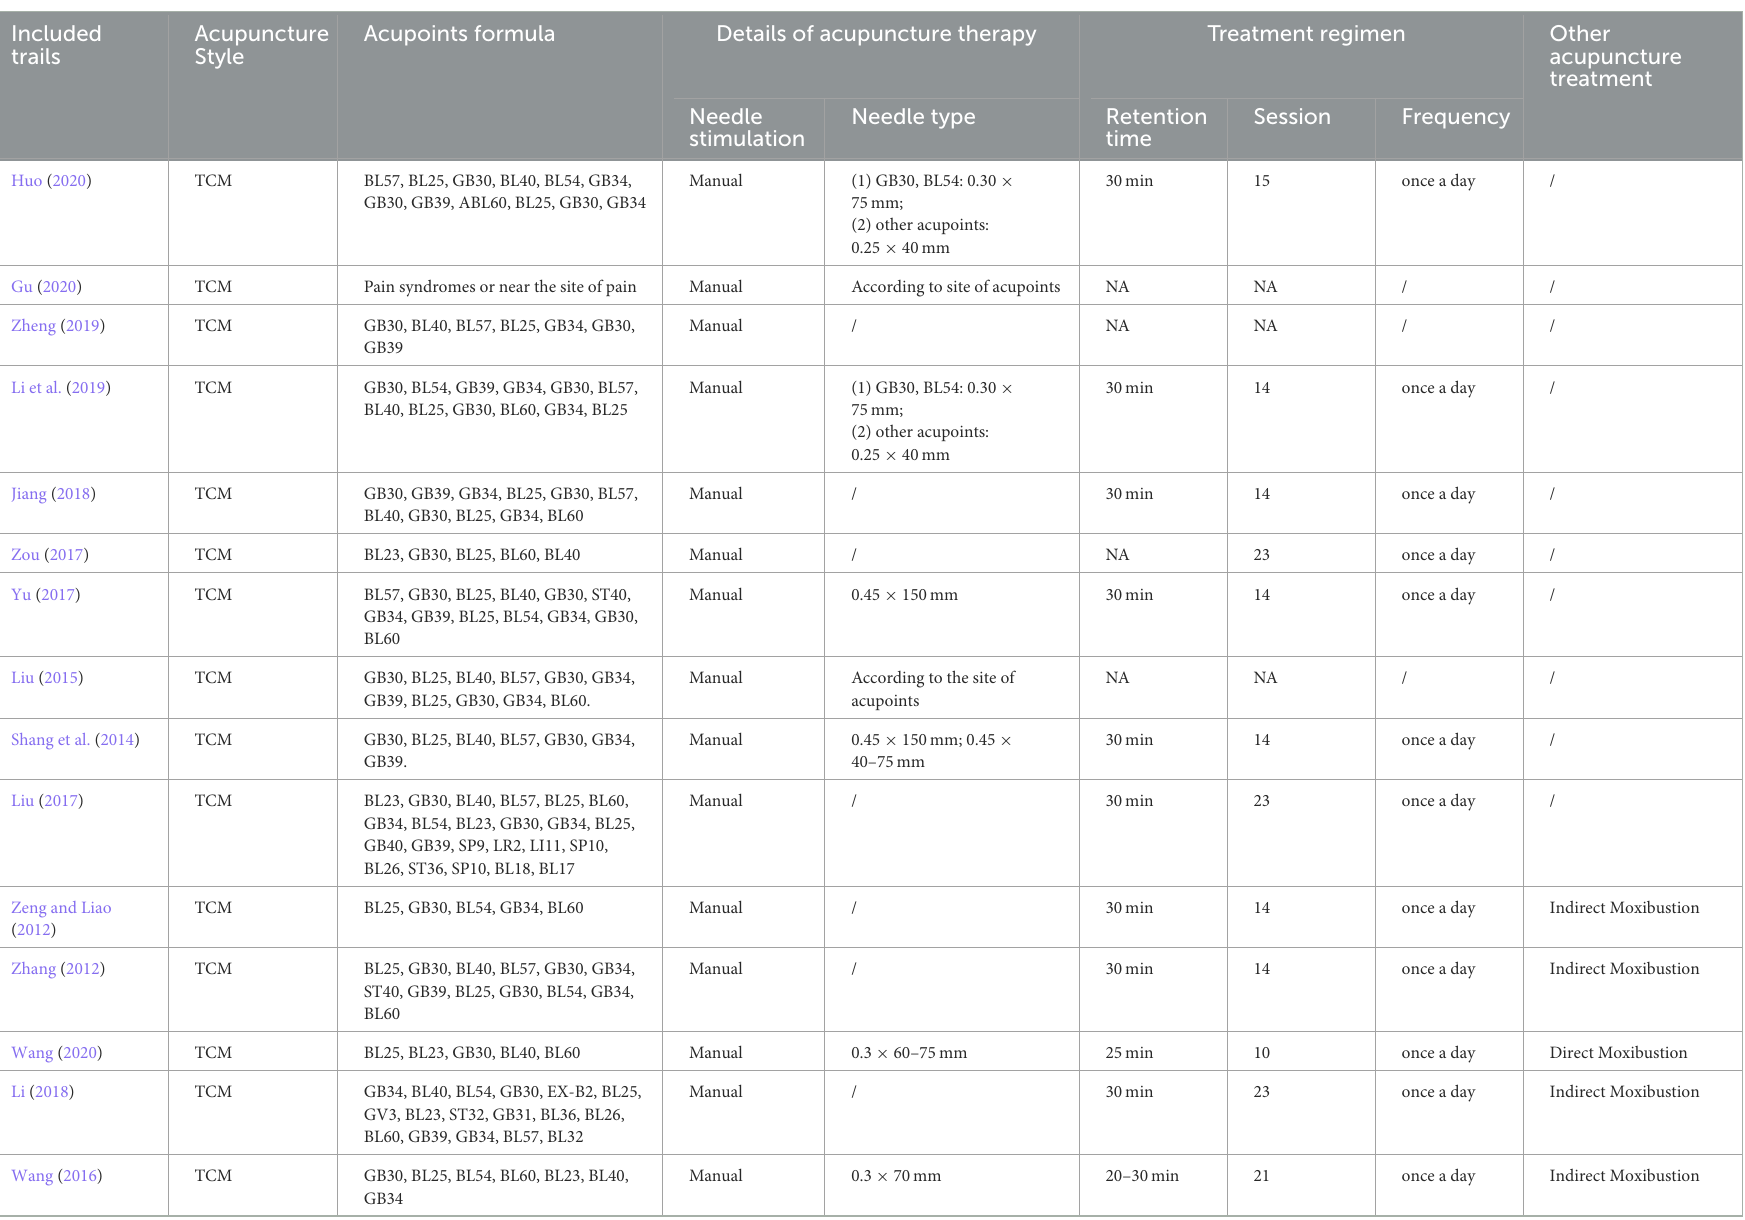
TABLE 2 Details of characteristics of acupuncture